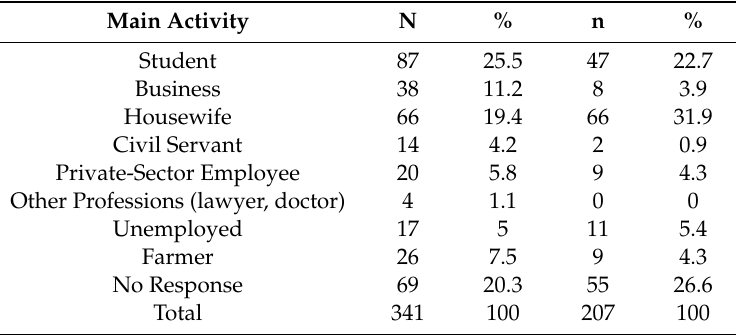
Table 2. Socio-professional activities in Syria.